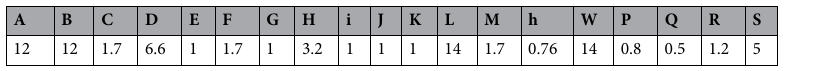
Table 2. Dimensions of the proposed antenna (in mm).